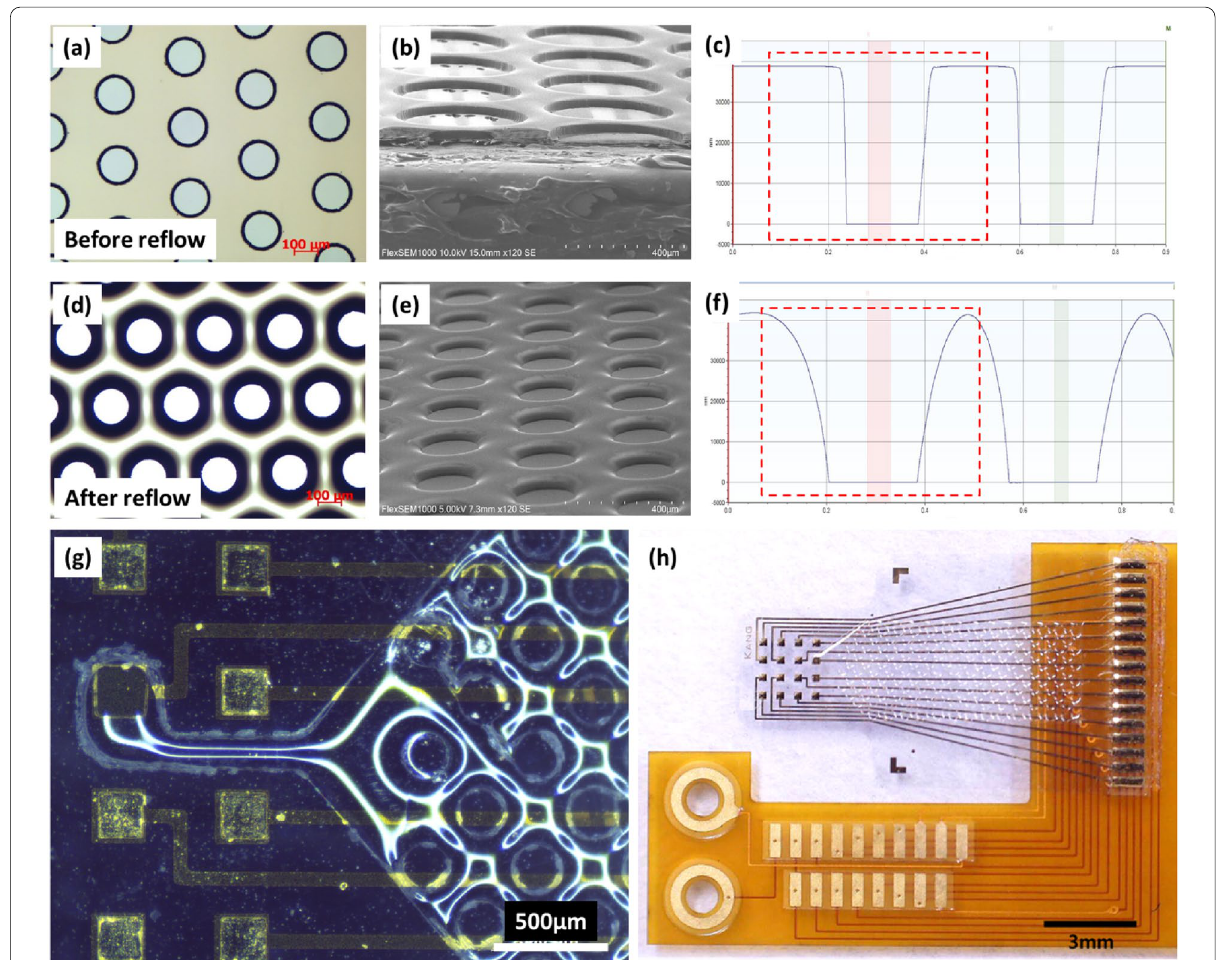
Fig. 5 Images of the crater‑shaped structures and the completed μFIC. The optical images ( a , d ) and scanning electron microscope (SEM) images ( b , e ) are compared before and after PR reflow. c , f The surface profiles of PR before and after PR reflow. g , h The optical images of the fabricated μFIC with crater‑shaped structures aligned in a zigzag